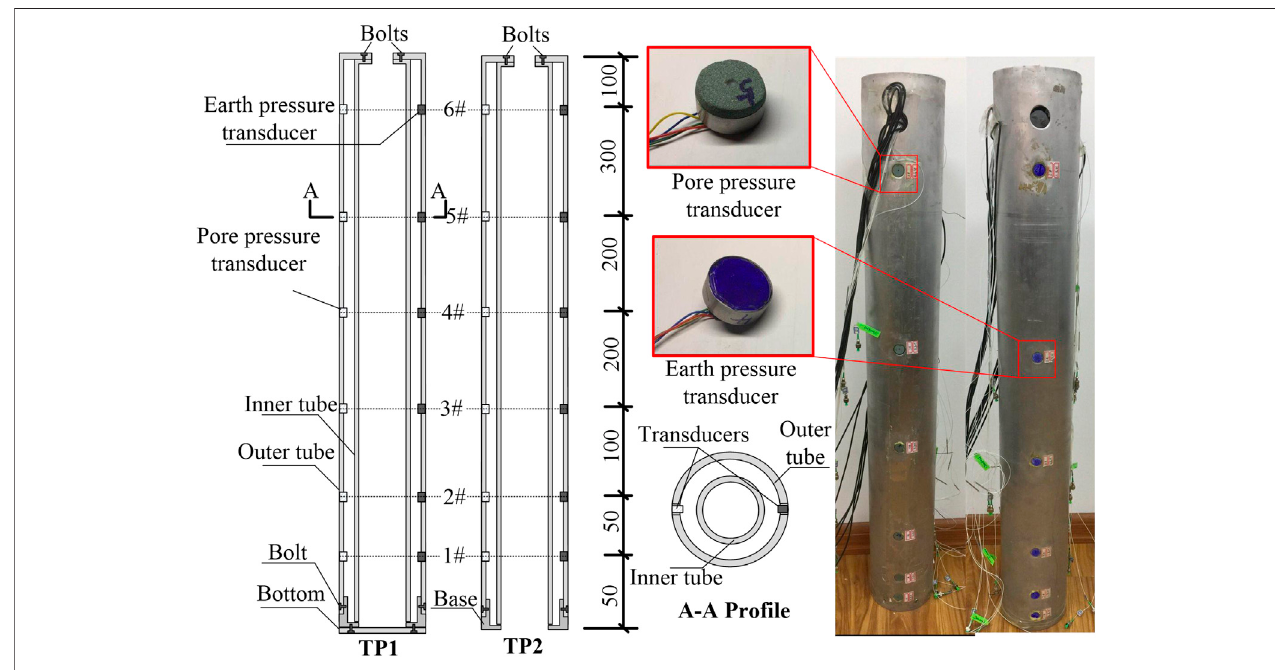
FIGURE 2 | The model piles structure and transducers mounting